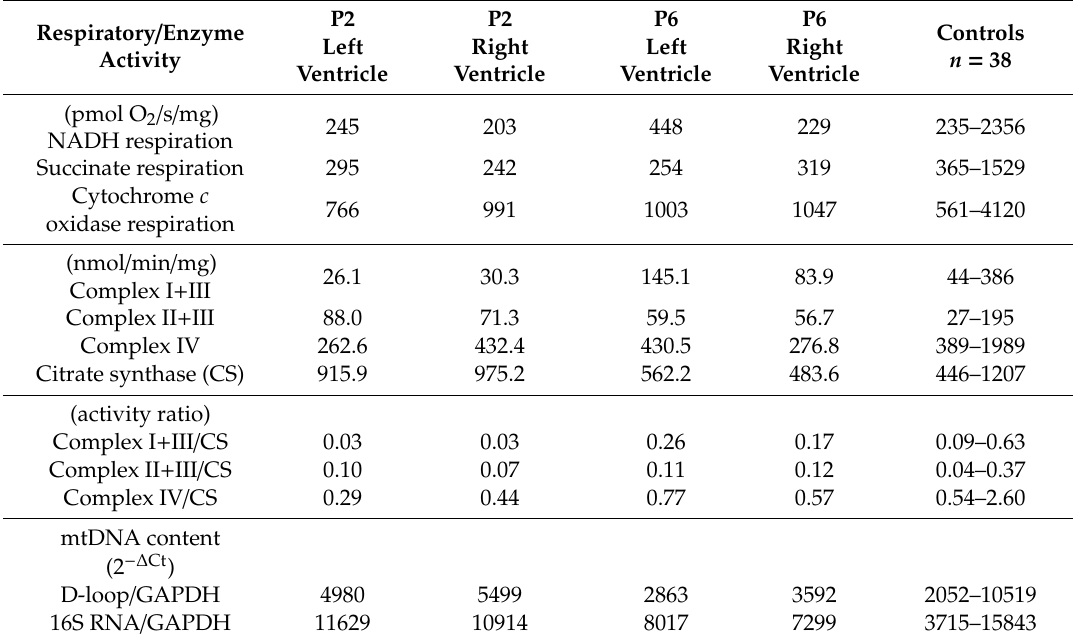
Table 2. Activities of respiratory chain enzymes and mtDNA content in hearts of proband 2 and 6.